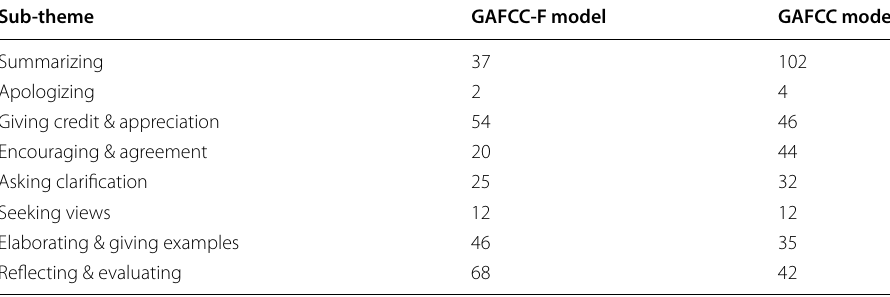
Table 3 Coding of posts in the two gamification design models (original posts and peer-feedback)